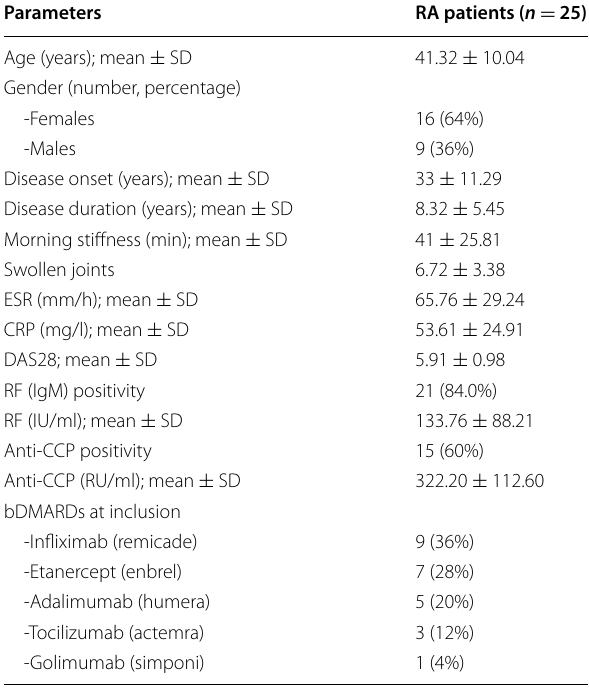
Table 1 Baseline features of rheumatoid arthritis